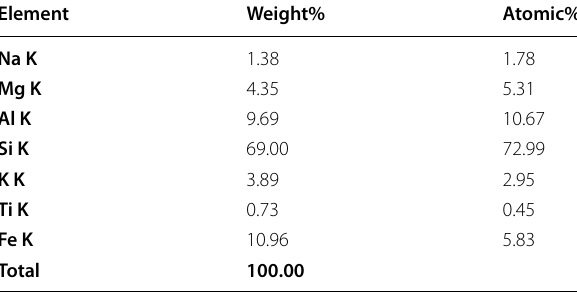
Table 1 Energy-dispersive X-ray spectroscopy analysis of the elemental composition of the diatom frustule of mud powder